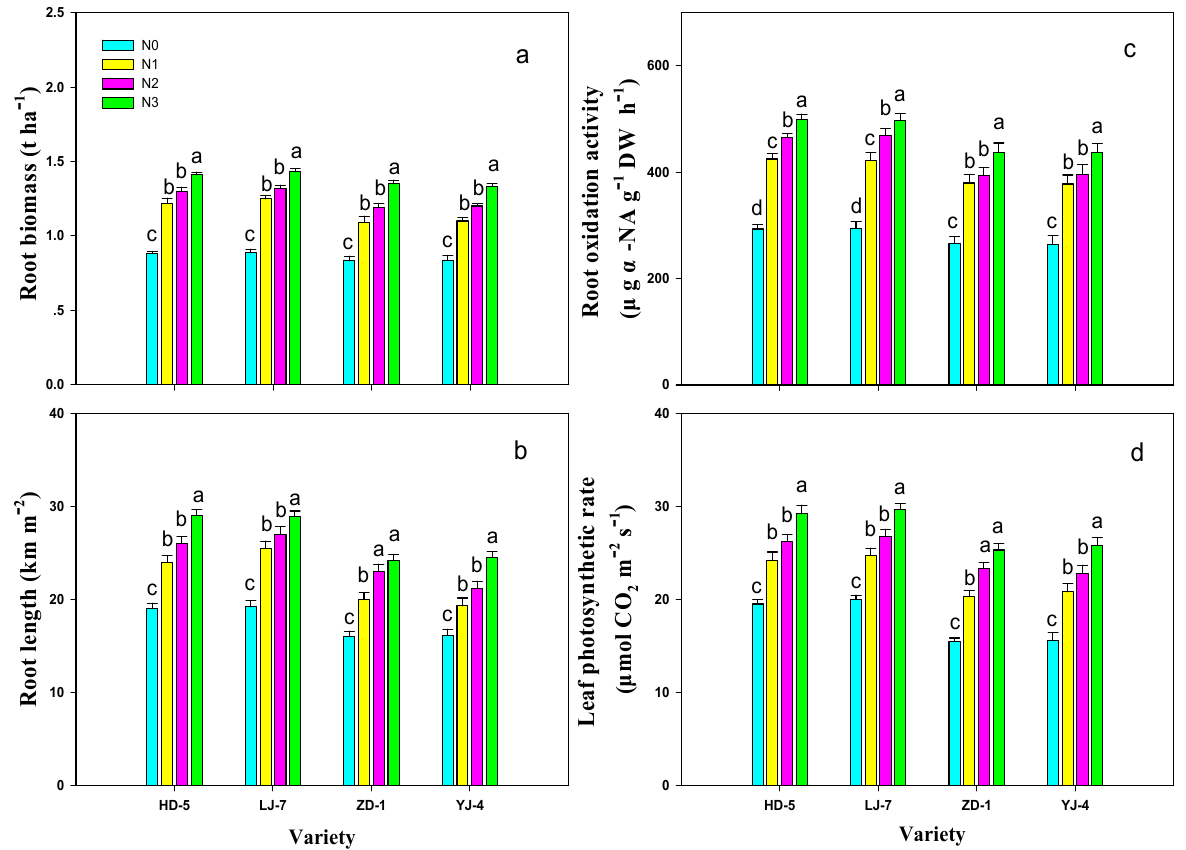
Figure 3. Root biomass ( a ), root length ( b ), root oxidation activity ( c ), and leaf photosynthetic rate ( d ) of rice at heading under different N treatment: the vertical bars represent the ±standard error of the mean (n = 5), where these exceed the size of the symbol. No shared letter above the column indicates statistical significance at the p = 0.05 level within the same variety. N0, zero-N control; N1, panicle N applied at spikelet differentiation (SD); N2, panicle N split at PI and SD; and N3, panicle N applied at panicle initiation (PI). HD-5, Huaidao 5; LJ-7, Lianjing 7; ZD-1, Zhongdao 1; and YJ-4, Yangjing 4038.